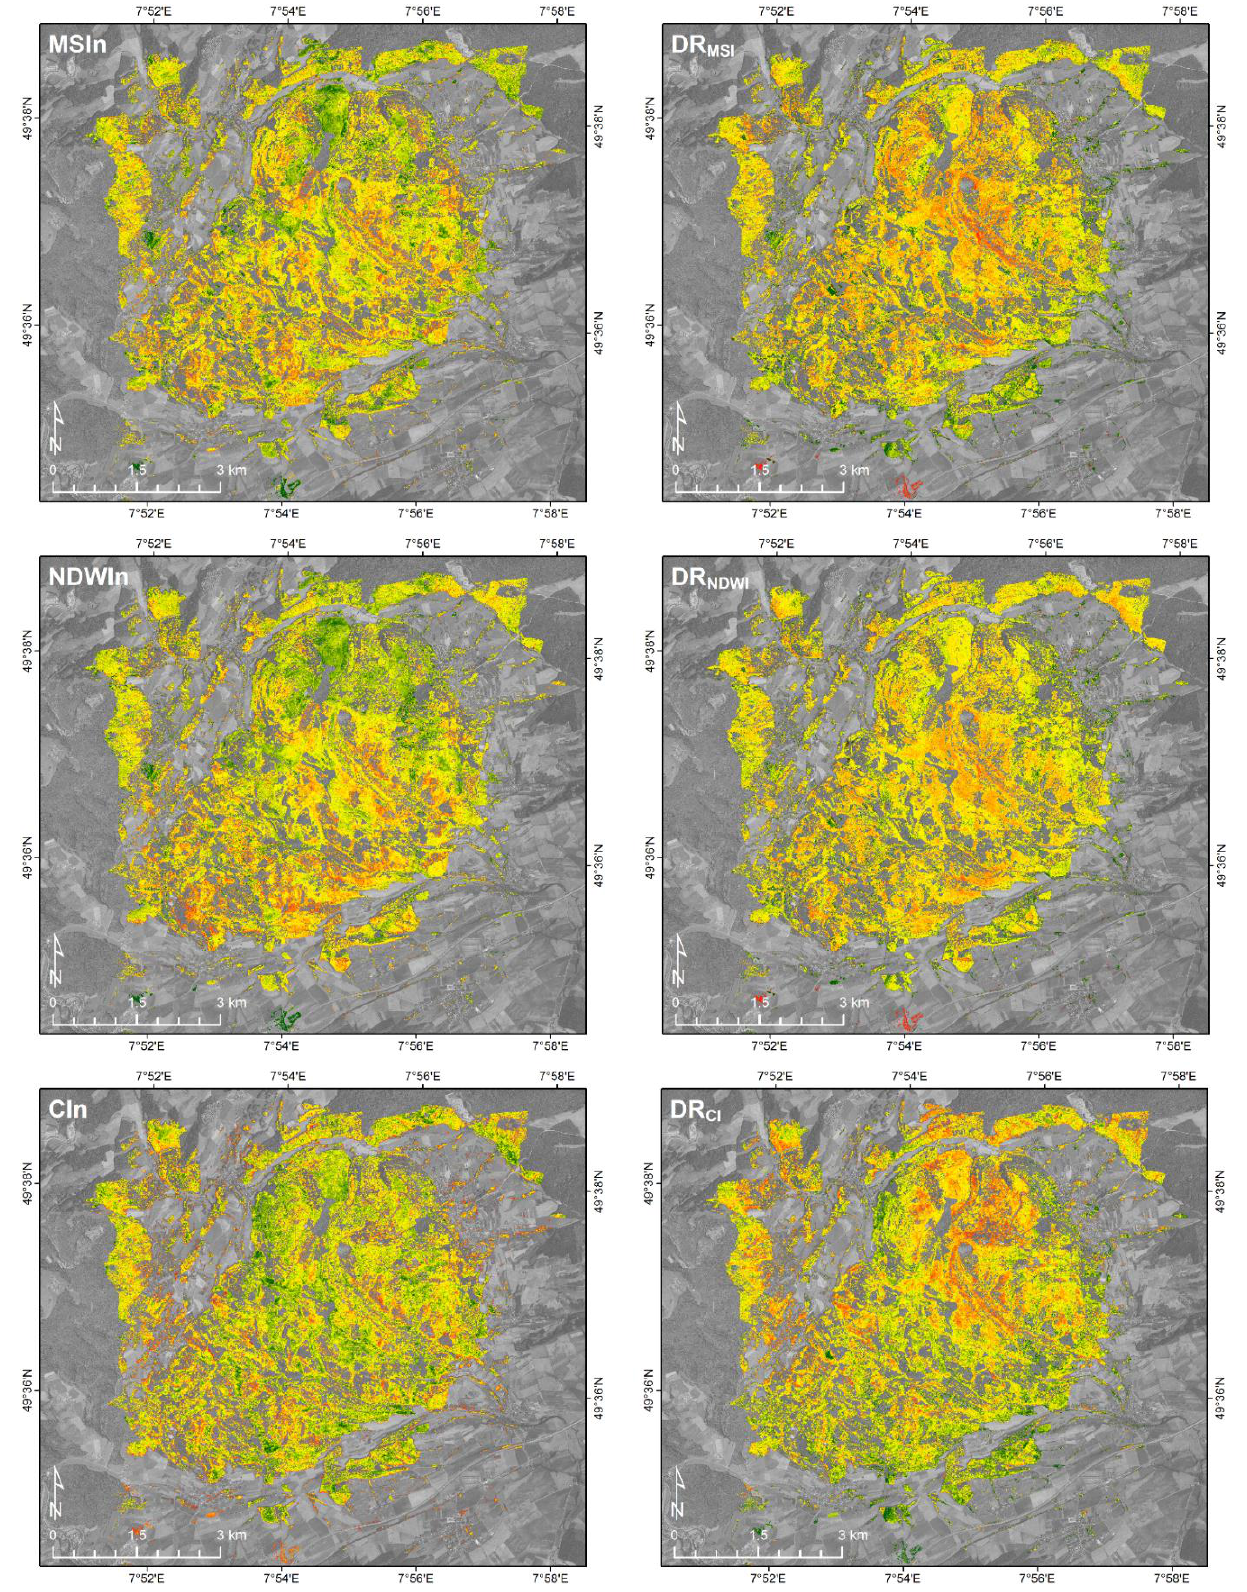
Figure 11. Maps of the normalized water- and chlorophyll-related indices ( left ) in comparison to the corresponding double ratio indices ( right ). All maps are colored from red (mean – 2 standard deviations) to green (mean + 2 standard